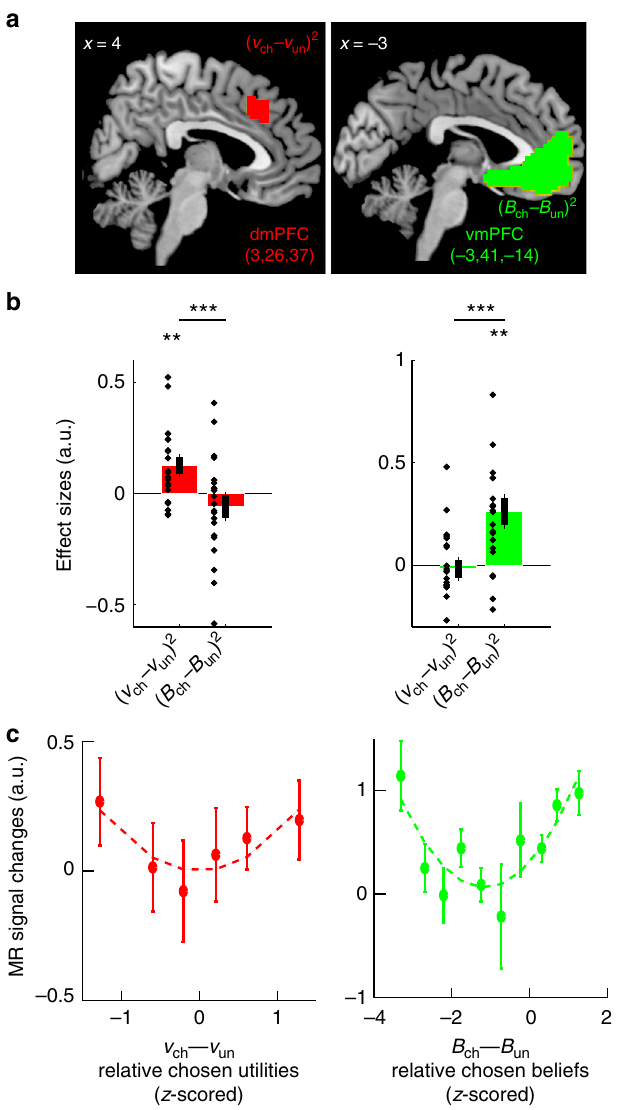
Fig. 7 Prefrontal activations encoding normalised utilities and state beliefs. a Topography of fMRI activations associated with relative normalised utilities ( v chosen − v unchosen ) 2 (red) and relative state beliefs ( B chosen − B unchosen ) 2 (green) between bandits (Model MIX). Activations are thresholded at p <0.05 (T-tests, voxel-wise corrected for family-wise errors over the frontal lobes, MNI coordinate Y > 0; cluster-wise threshold p < 0.05) and superimposed on sagittal anatomical slices (MNI template). Numbers in brackets indicate MNI- coordinates of activation peaks (See Supplementary Table 4). b Quadratic effect sizes averaged over activation clusters shown in A (left: dmPFC; right: vmPFC; leave-one-out procedure removing selection biases). ** p < 0.01; *** p < 0.001 (T-tests). c Activations averaged over clusters shown in a and plotted against relative chosen normalised utilities ( v chosen − v unchosen ) (left, dmPFC, the linear component being factored out is shown in Fig. 5) and relative chosen beliefs ( B chosen − B unchosen ) (right, vmPFC, no linear component factored out) z - scored within participants. Error bars are s.e.m. across participants ( N =